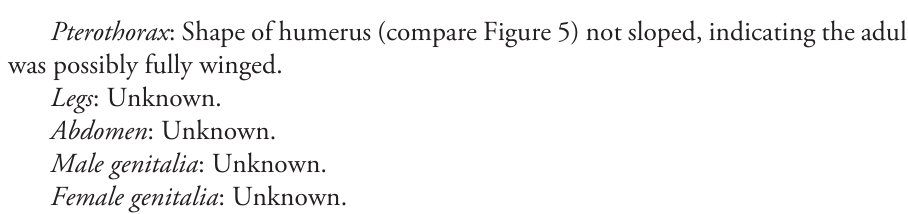
Pterothorax : Shape of humerus (compare Figure 5) not sloped, indicating the adult was possibly fully winged. Legs : Unknown. Abdomen : Unknown. Male genitalia : Unknown. Female genitalia :